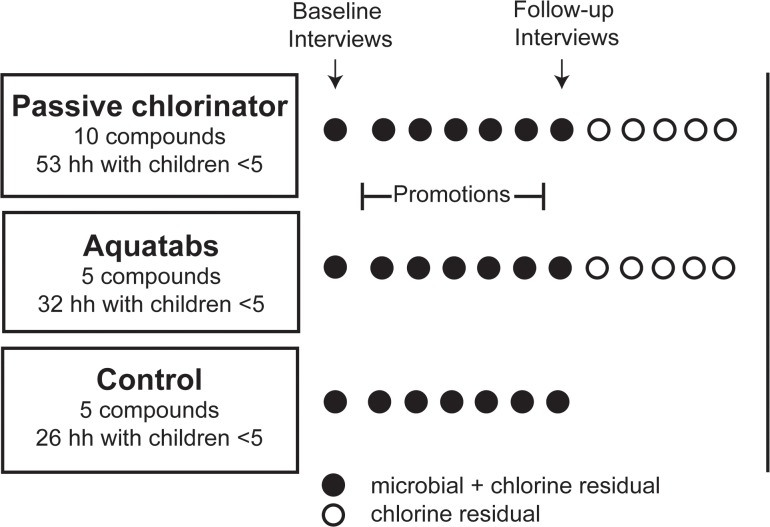
Data collection schedule for households (hh) with children under five years of age in study compounds.Solid black circles indicate water sampling for microbial and chlorine residual analysis, open circles indicate water sampling for chlorine residual analysis only. The duration of the follow-up data collection period (post-baseline and hardware delivery) was 10 months. Interviews were conducted at baseline and at five months of follow-up.